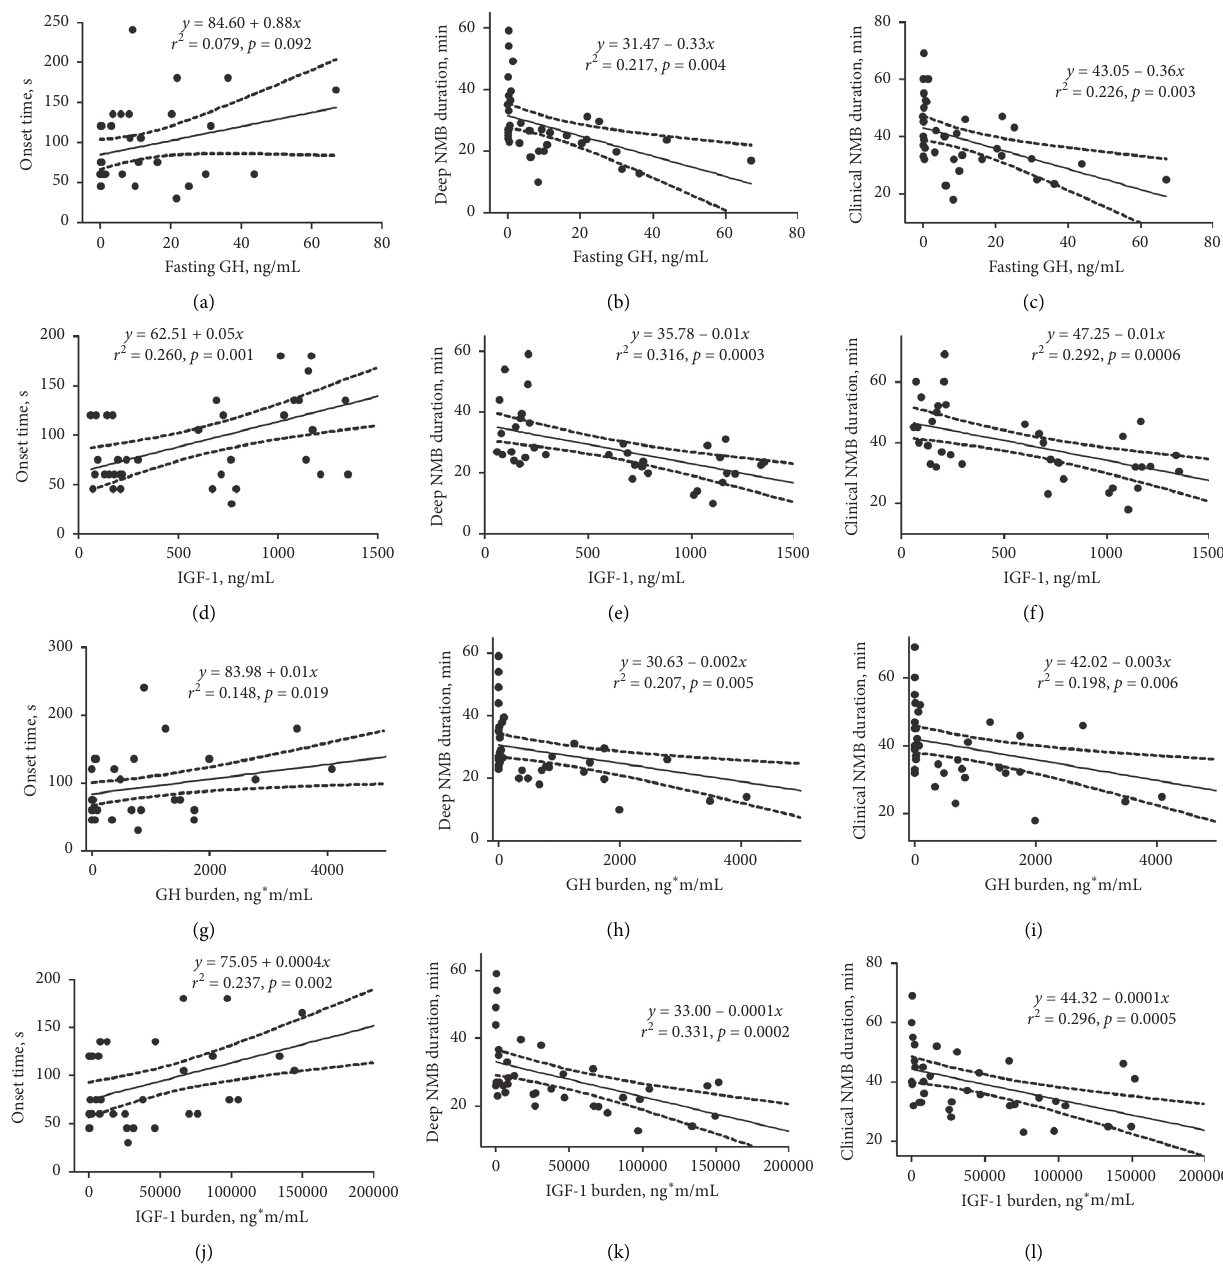
Figure 2: Scatter plots representing correlations between hormone indexes and neuromuscular blockade (NMB) indexes. The hormone indexes included random GH, IGF-1, GH burden, and IGF-1 burden. The GH burden was defined as the product of random GH and disease duration, and the IGF-1 burden was defined as the product of IGF-1 and disease duration. In each scatter plot, the solid straight line is the best fit line representing the linear regression result. The dashed curves on both sides of the best fit line indicate the 95% confidence interval. The linear regression equation, r 2 , and ( p ) value are labeled on the top right corner of the scatter